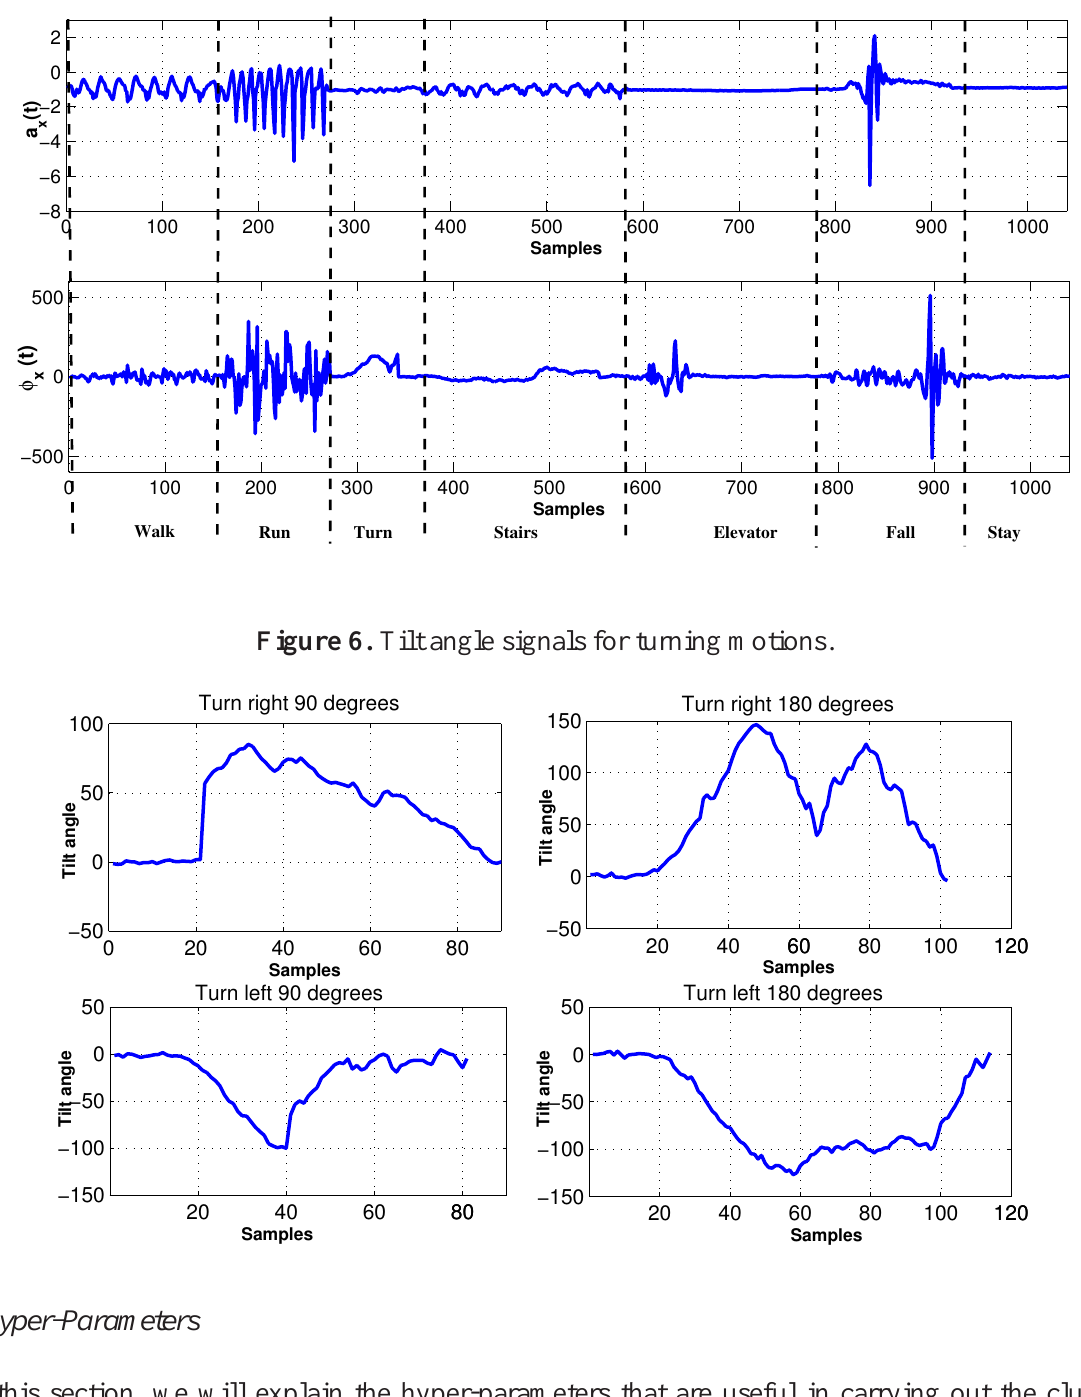
Figure 5. The acceleration ( a the MEMS sensor.